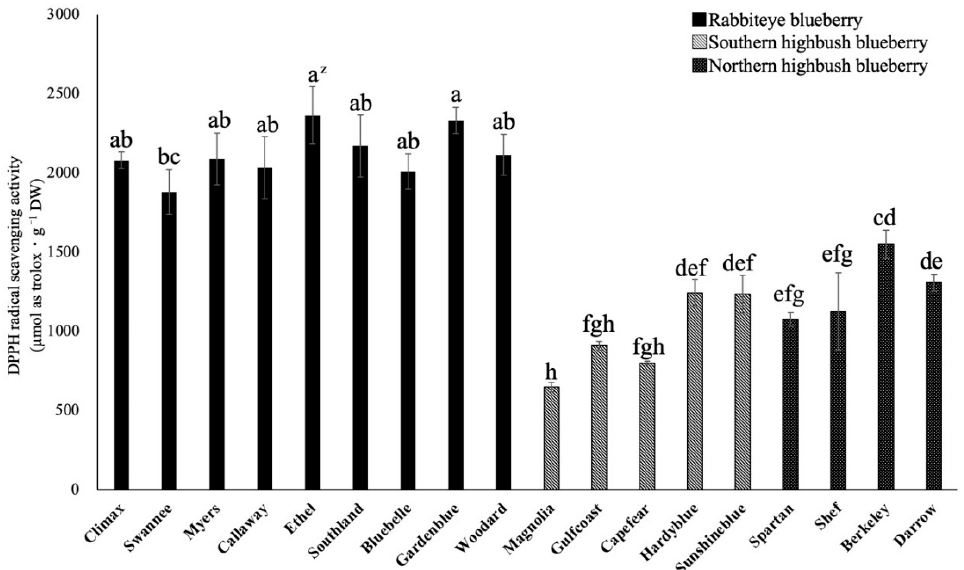
Figure 4. Comparison of the antioxidant activity in mature leaves of blueberry varieties. z Different letters among varieties represent significant differences at 5% level as determined by Tukey’s multiple range test (n = 3).